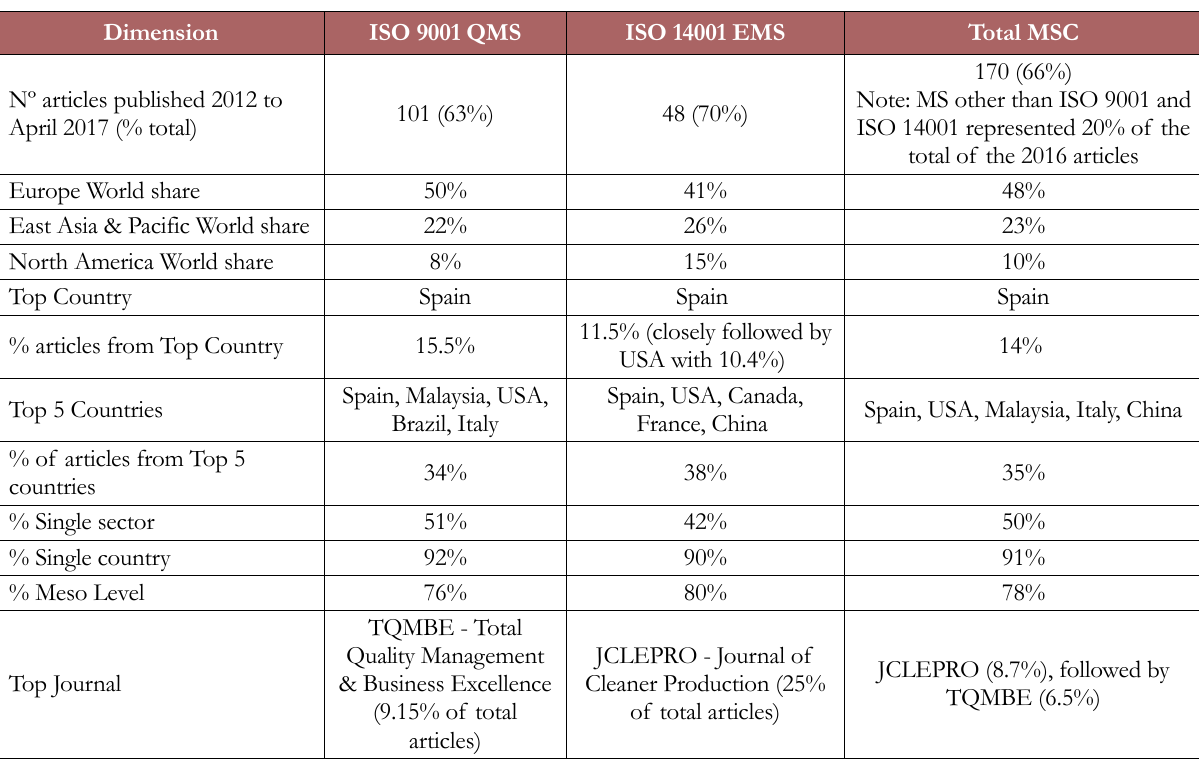
Table 2. Summary Comparison of ISO 9001 QMSC and ISO 14001 EMSC